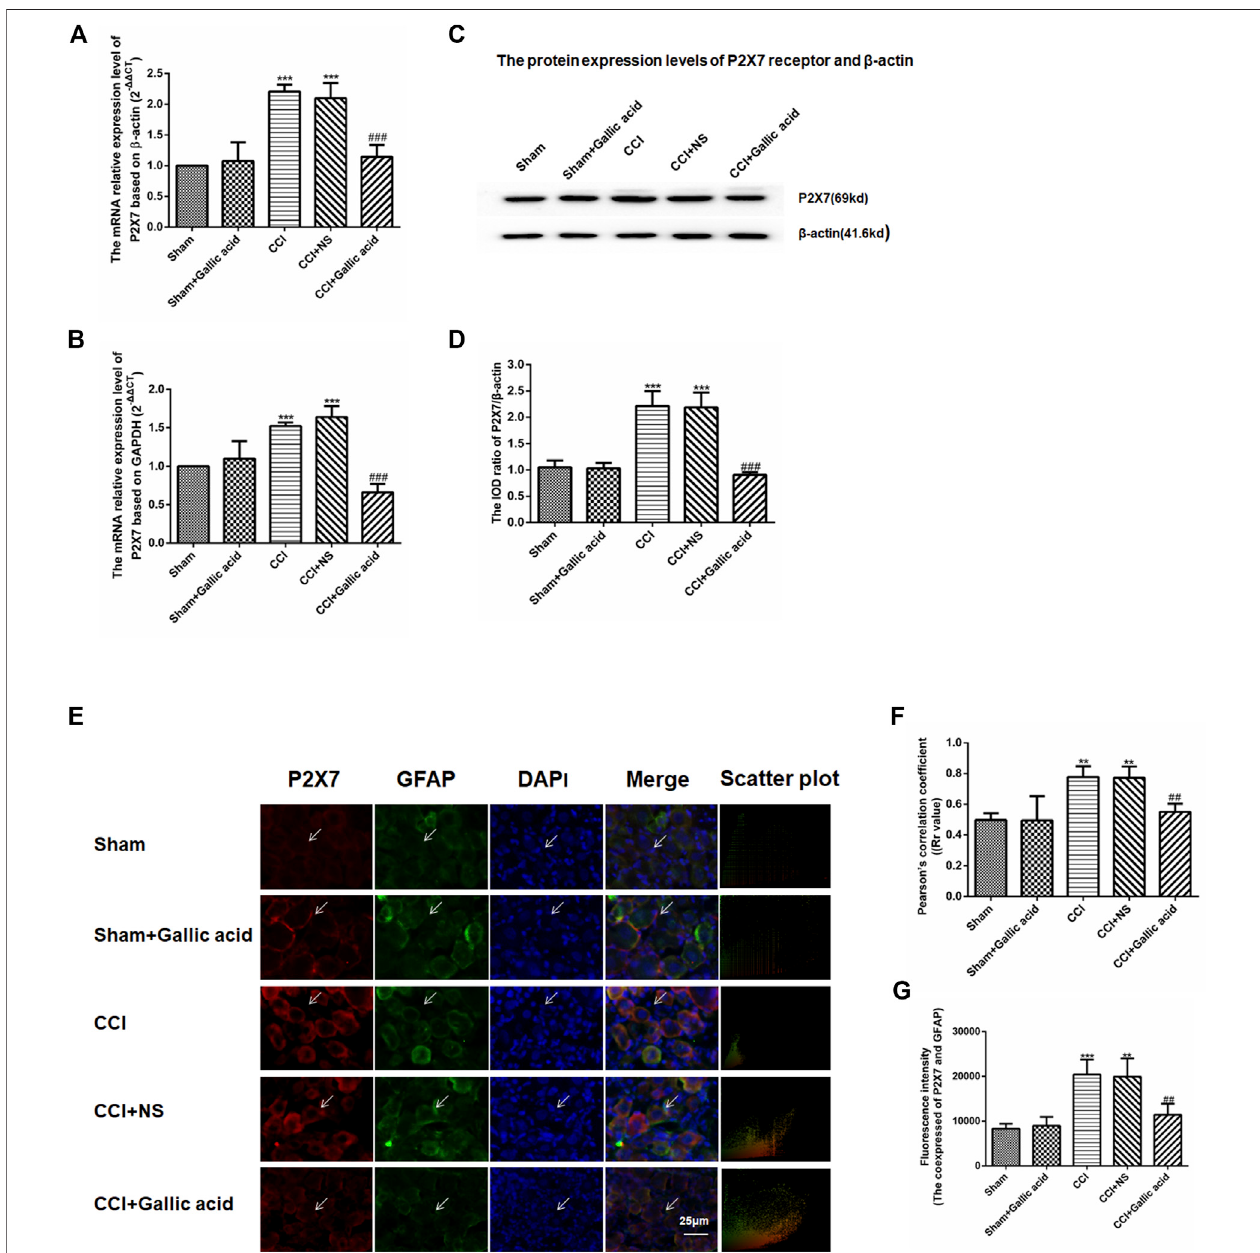
FIGURE 2| Effect of gallic acid on the expressionof the P2X7receptor. (A). The expression ofP2X7 mRNA was detected by qRT-PCRusing β -actin as the housekeeper gene (F (4, 10) (cid:2) 21.56, p < 0.001). (B). The expression of P2X7 mRNA was detected by qRT-PCR using GAPDH as the housekeeper gene (F (4, 10) (cid:2) 49.25, p < 0.001). (C). TheproteinexpressionofP2X7and β -actinintheDRGwasdetectedbyWesternblotting. (D). Therelativeproteinexpression ofP2X7receptor(F (4, 10) (cid:2) 56.34, p < 0.001). (E). EffectofgallicacidonthecoexpressionofP2X7andGFAPinDRG. ThecoexpressionofP2X7 andGFAPintheDRGwasdetected byadouble-labelimmuno fl uorescenceassay.Arrowsindicateactivecells.Scalebar:25 µm. (F). Pearsoncoef fi cientanalysiswasusedtodetectthecorrelationbetween P2X7 and GFAP. Rr value represents the degree of correlation between the coexpression of P2X7 and GFAP. Rr is a value between 1 and − 1, where one means the variable is completely positively correlated, 0 means irrelevant, and − 1 means completely negatively correlated (F (4, 10) (cid:2) 17.92, p (cid:2) 0.0001). (G). The fl uorescence intensity of the coexpression of P2X7 and GFAP (F (4, 10) (cid:2) 17.58, p (cid:2) 0.0002). One-way ANOVA was used to detect the mRNA and protein expression of P2X7 receptorsandthe fl uorescenceintensityofcoexpressionofP2X7andGFAP.Eachgroupconsistedofeightrats.Dataarepresentedasmean ± SEM.*** p < 0.001versus the Sham group, ### p < 0.001 versus the CCI group.